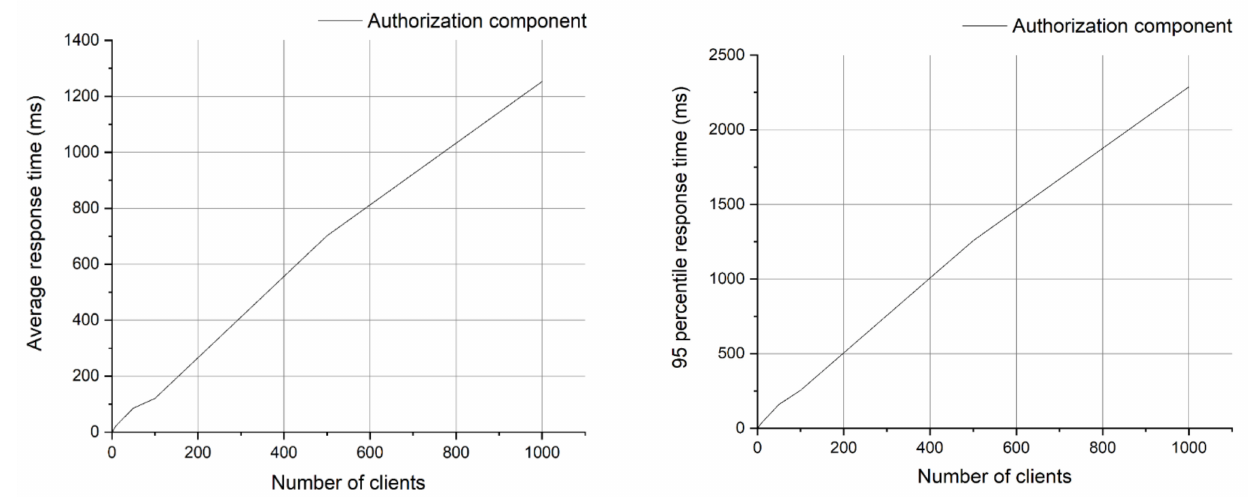
Figure 10. Average response time and 95th percentile response time.